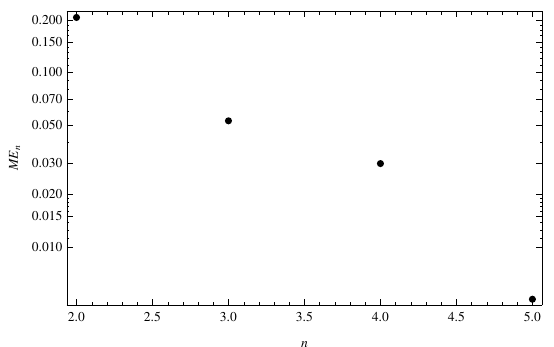
Figure 9: Logarithmic plots of the values of the maximal error pa- rameters ME n for n = 2, 3, 4, 5